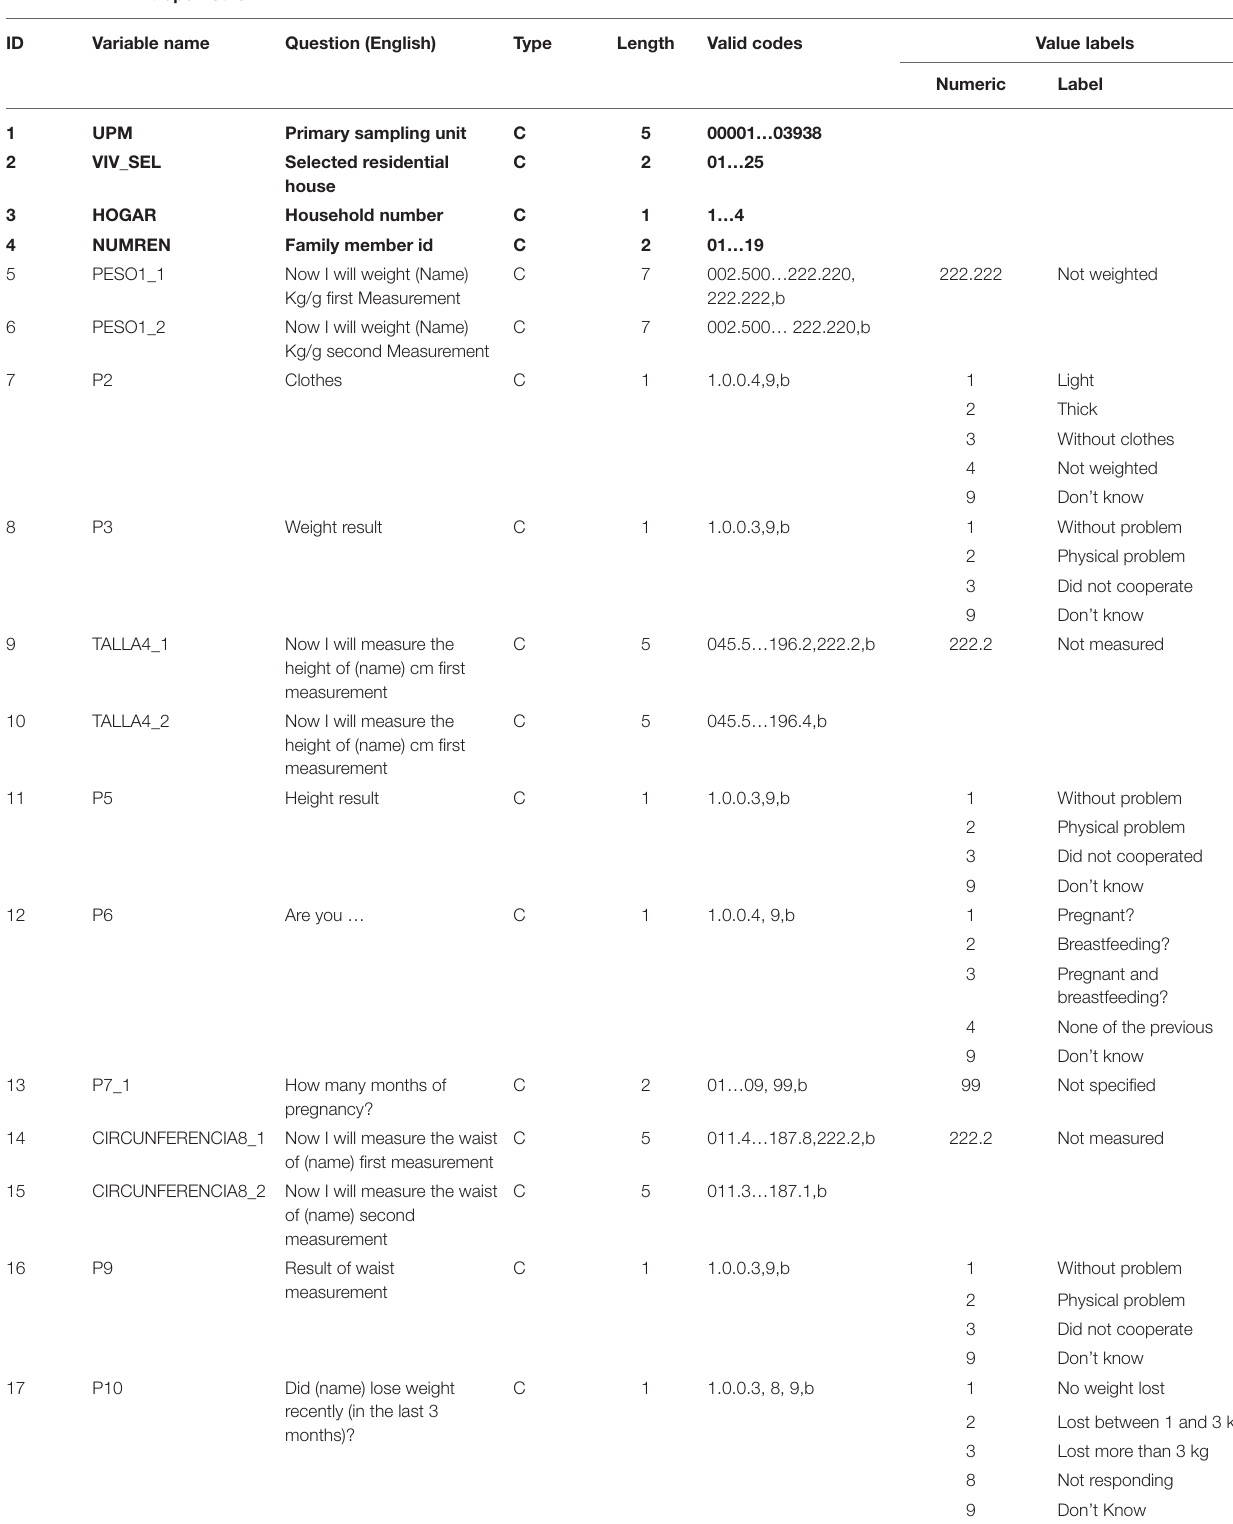
TABLE 2 | The complete structure of one of the anthropometric tables (ENSANUT 2018). TABLE NAME: